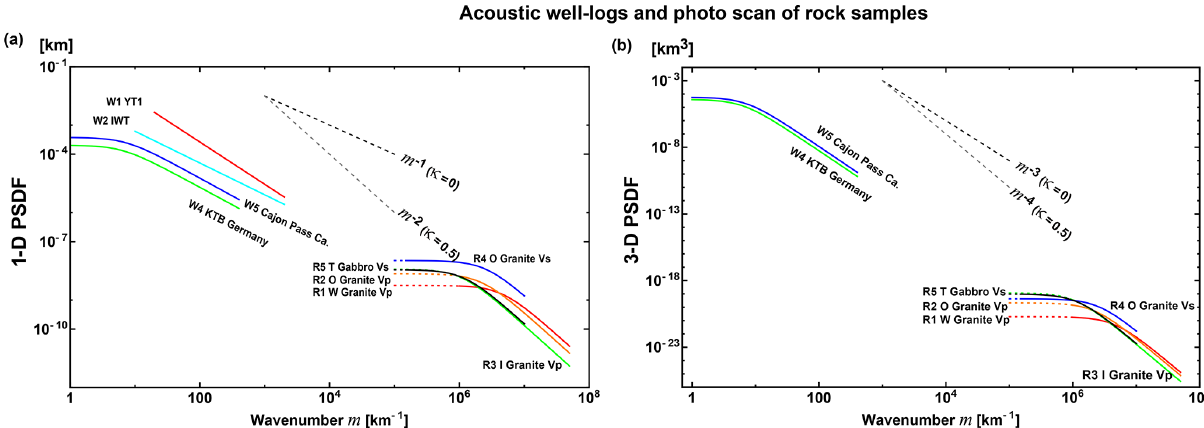
Figure 2. (a) 1-D PSDF vs. wavenumber for rock samples and acoustic well logs. (b) Converted 3-D PSDF vs. wavenumber, where the randomness is supposed to be isotropic. See labels in Table